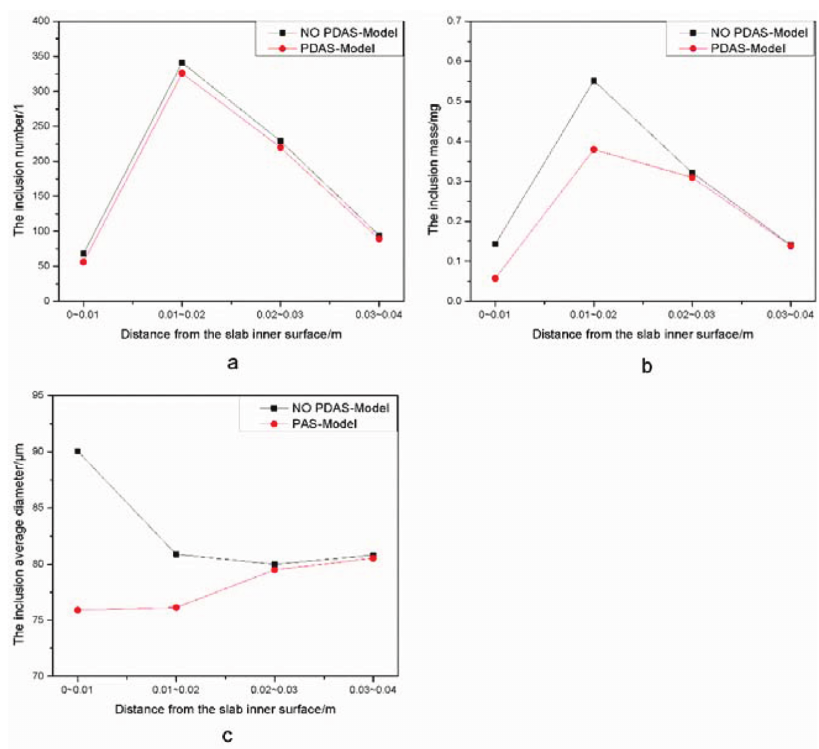
Figure 12: The relationships between the inclusion number (a), mass (b), average diameter (c) and the distance from the slab broad